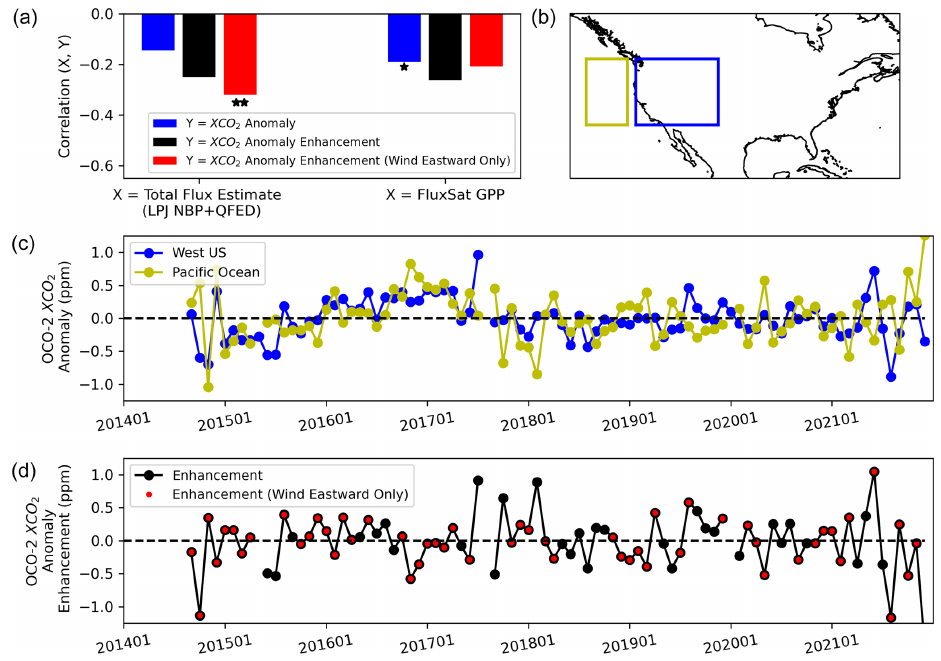
Figure 6. (a) Pearson correlation coefficients between the XCO 2 anomalies and model-based total surface CO 2 flux anomalies (LPJ model and QFED biomass burning) as well as with observation-based FluxSat ( ∗∗ p value < 0.05; ∗ p value < 0.1). (b) Map of Western US and background Pacific Ocean background domain definitions. (c) Spatially averaged OCO-2 XCO 2 anomalies in the Western US and background Pacific Ocean. (d) Western US XCO 2 anomaly enhancements from the background Pacific Ocean OCO-2 XCO 2 anomalies. Red symbols are months when the incoming wind direction from the Pacific Ocean was between − 60 and 60 ◦ angles from eastward reference